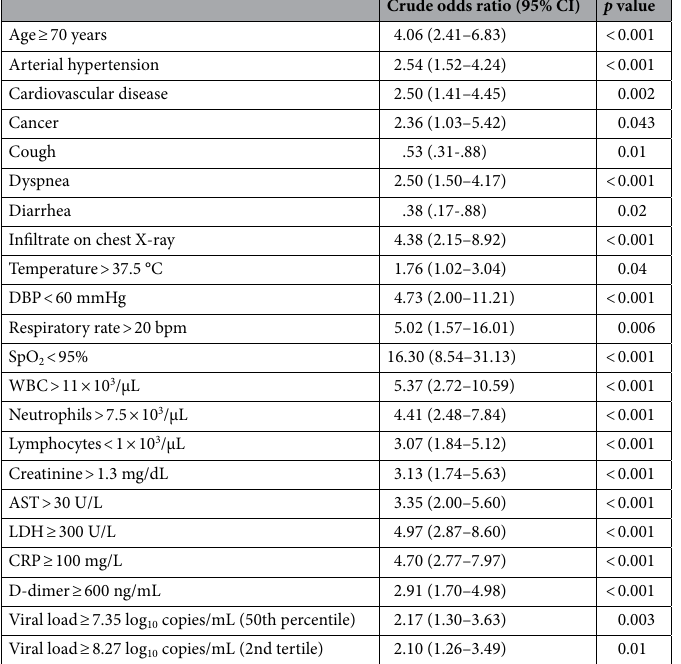
Table 4. Baseline risk factors for unfavorable outcome (intensive care unit admission and/or death): Univariable logistic regression